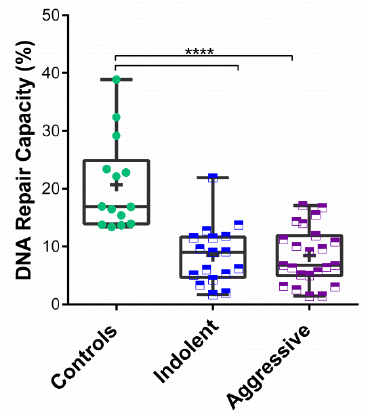
Figure 2. DNA repair capacity in prostate cancer patients with indolent and aggressive tumors. Based on their Gleason scores, the tumors from PCa cases were stratified into indolent ( n = 17) and aggressive ( n = 23). Symbols represent individual DRC values. Mean DRC value for each group is represented with a plus (+) sign. Asterisk (****) denotes statistical significance ( p = 0.001, Kruskal – Wallis test).